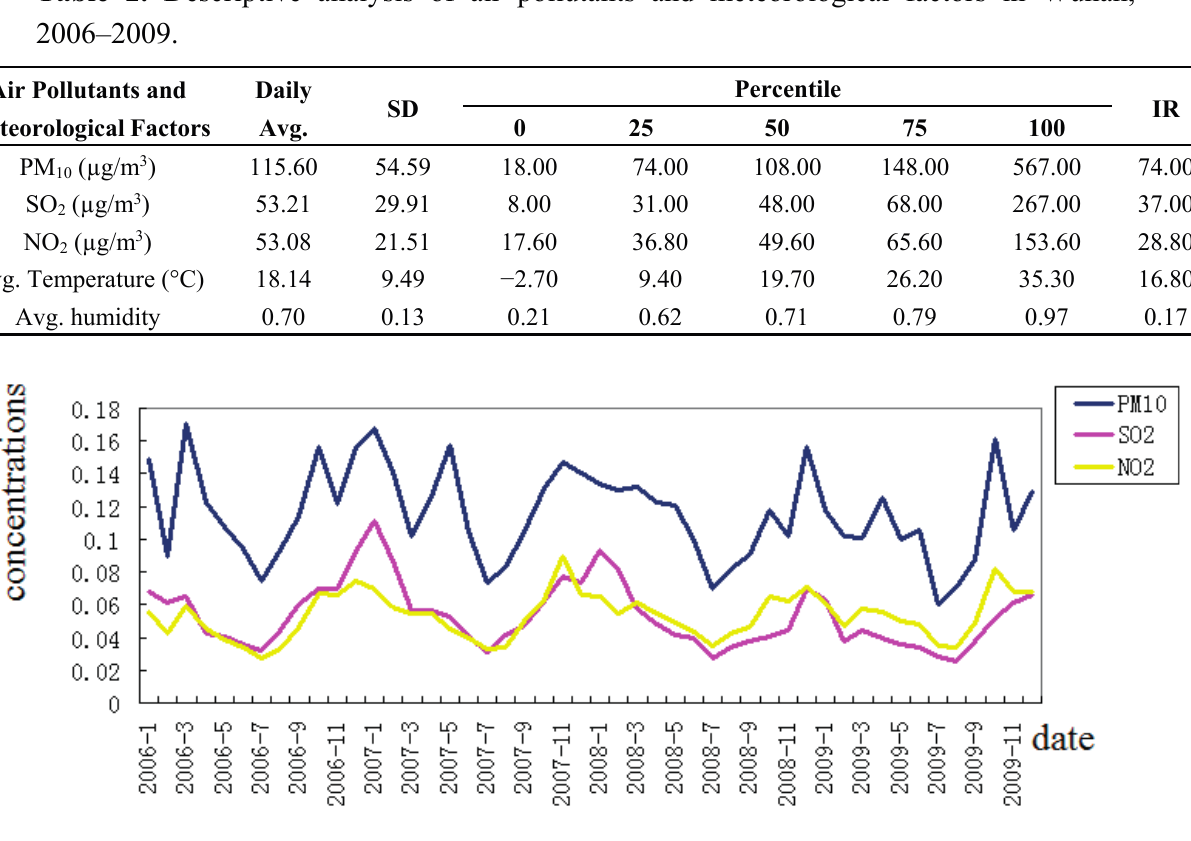
Figure 1. Monthly average concentrations ( μ g/m 3 ) of air pollutants during